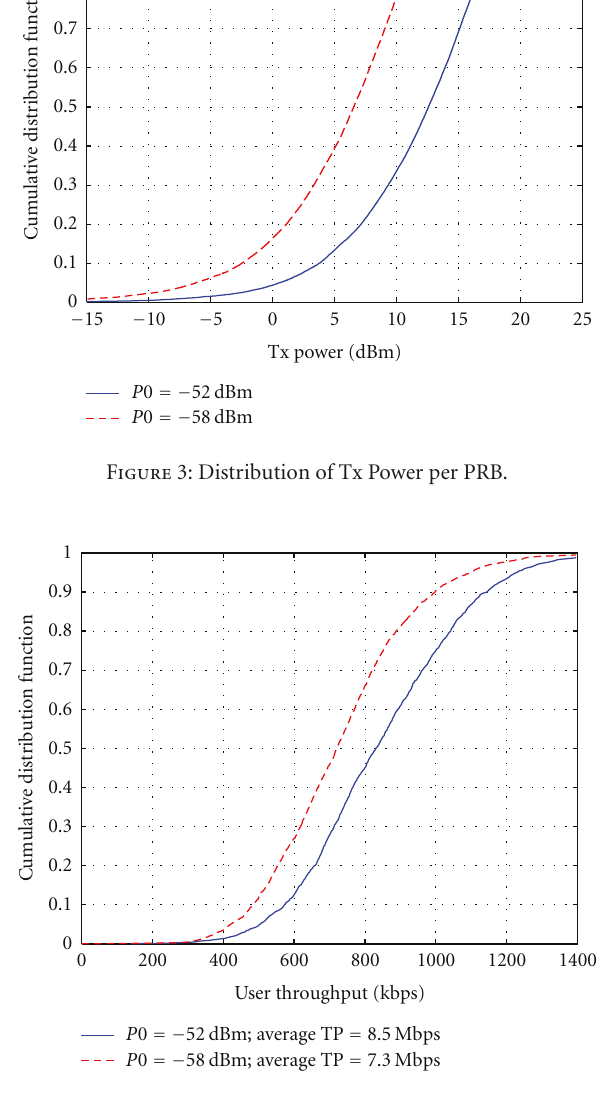
Figure 4: Distribution of user throughput in modified resource fair